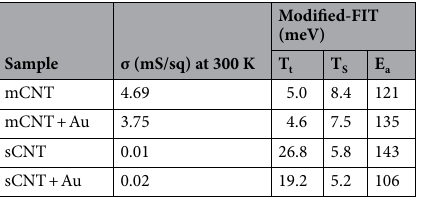
Table 1. The comparison of the conductivity changes at 300 K and FIT model